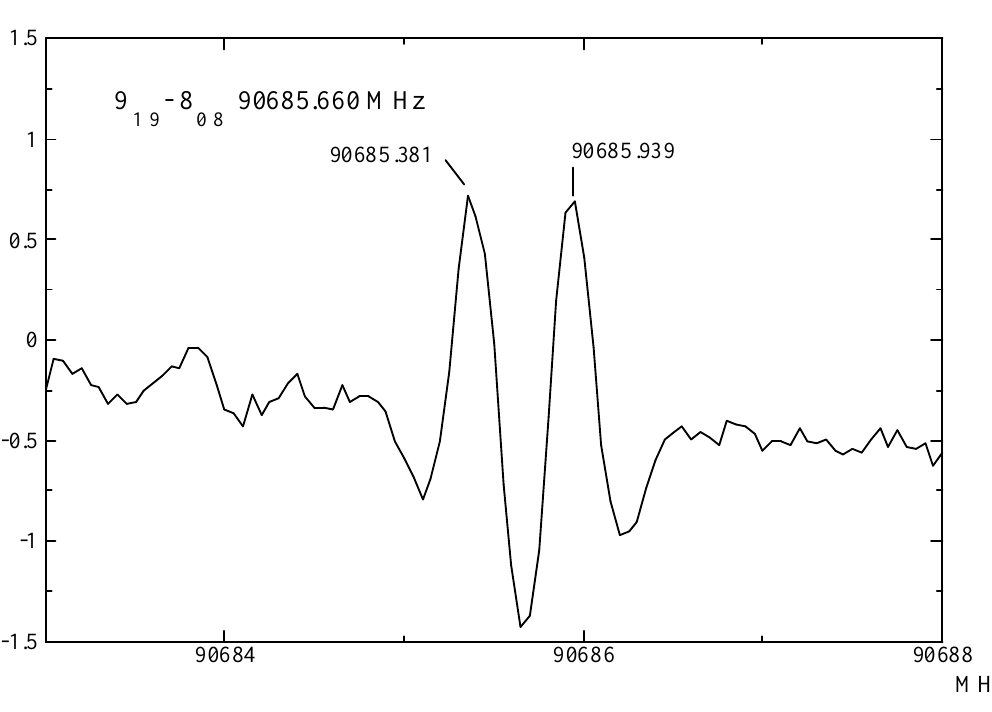
Figure 6. Absorption line for the 9